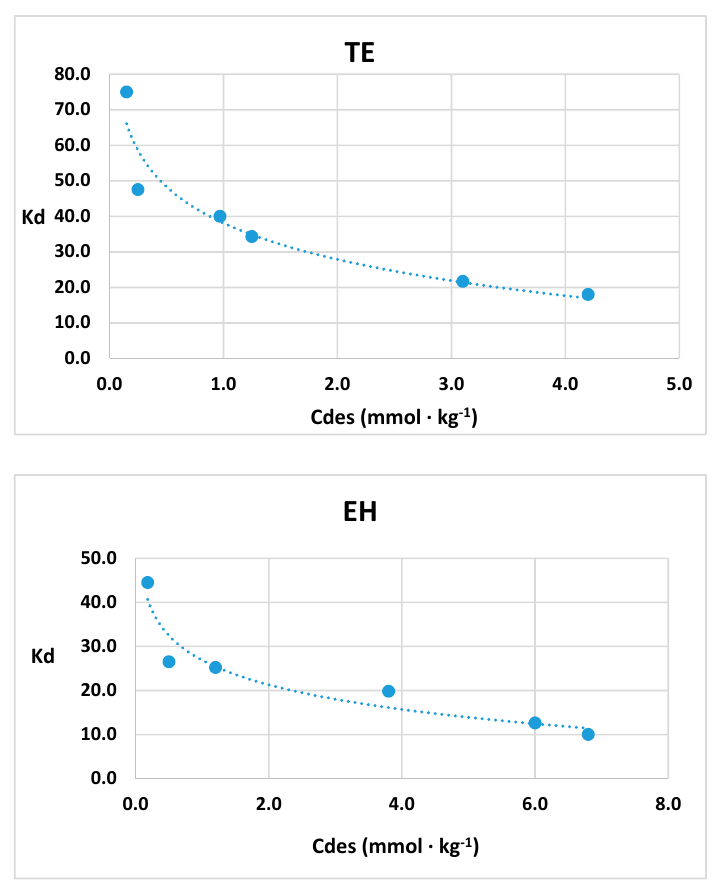
Figure 6. Patterns of Kd of the investigated soils versus equilibrium concentrations in the adsorption experiment.